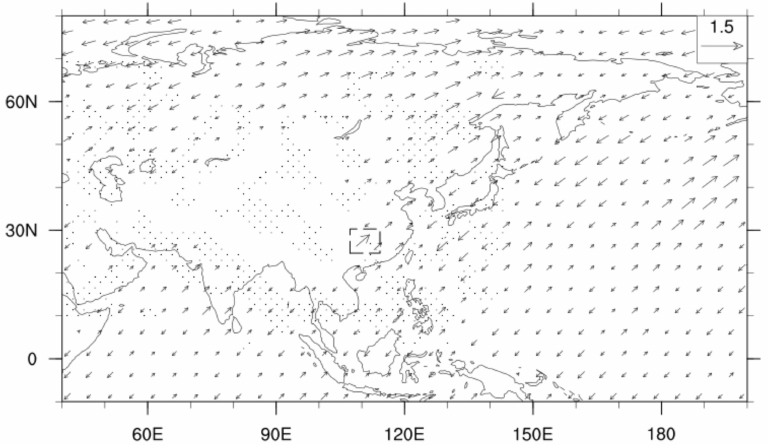
Figure 9. The 850 hPa wind field difference between the peak years and valley years, unit: mm/s, the dotted area indicates that zonal wind passed the 95% significance